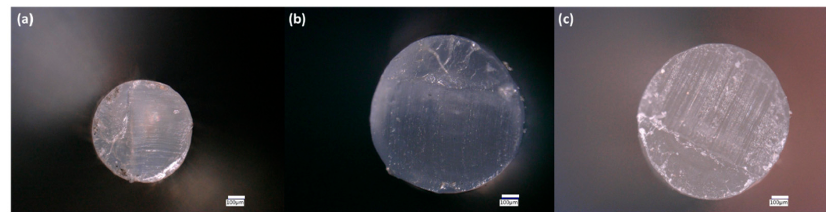
Figure 2. Digital microscopy cross-section images of: ( a ) PLA/PEG1k 90/10; ( b ) PLA/PEG2k 90/10; and ( c ) PLA/PEG10k 90/10.